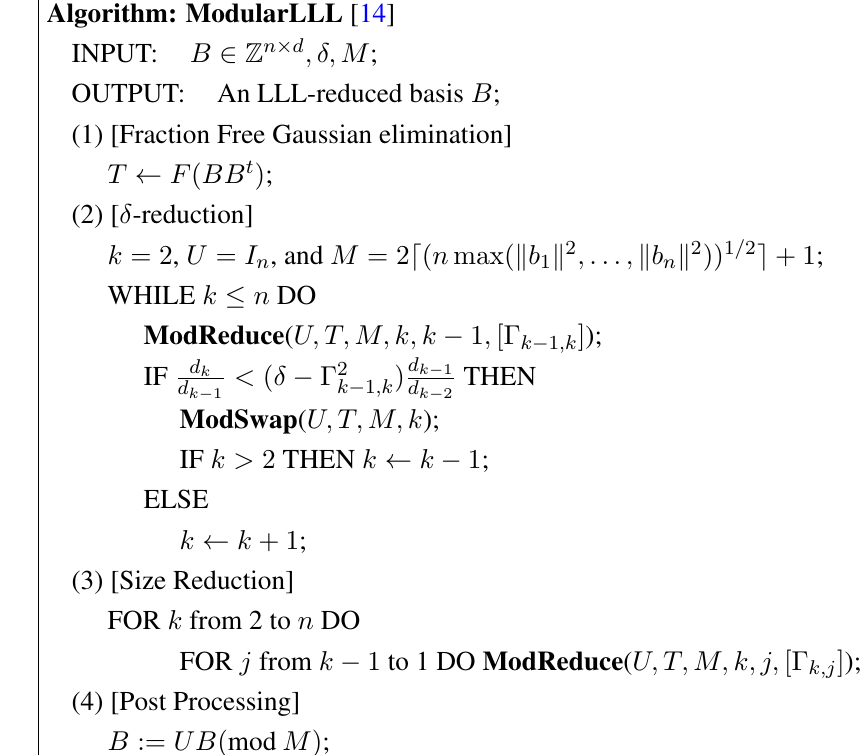
Figure 8. The Modular LLL Basis Reduction Algorithm.